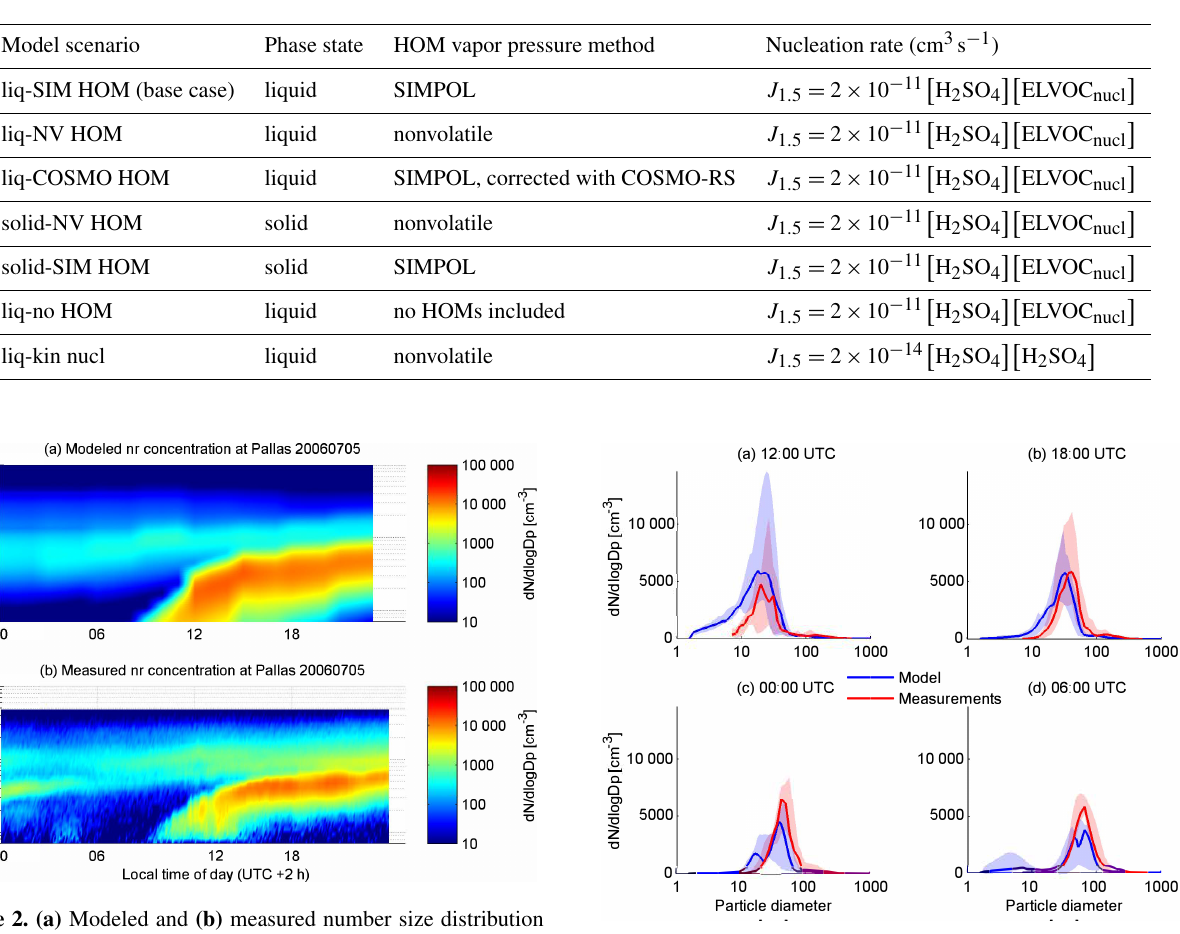
Figure 3. The modeled particles are assumed to be liquid and the va- por pressures of the HOMs are estimated with SIMPOL. Measured (red lines) and modeled (blue lines) median number size distribu- tions at (a) 12:00 and (b) 18:00UTC the day of the new particle formation event and at (c) 00:00 and (d) 06:00UTC the following day. The shaded areas are the values that fall between the 25th and 75th